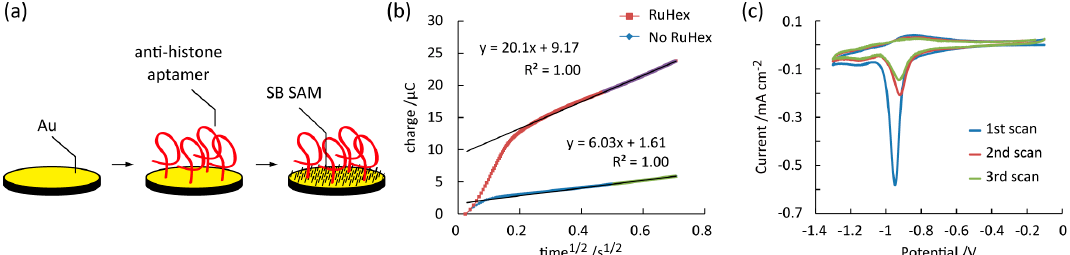
Figure 3. Surface functionalization of gold electrodes for specific recognition of histones. ( a ) Schematics showing a two-step introduction of anti-histone single-stranded DNA aptamers and sulfobetaine-3-undecanethiol ( SB) self-assembled monolayer (SAM) on a planar gold electrode. ( b ) Chronocoulometry with and without hexamine-ruthenium (III) chloride (RuHex) for determining the surface density of the aptamer. ( c ) Cyclic voltammetry for determining the surface density of SB